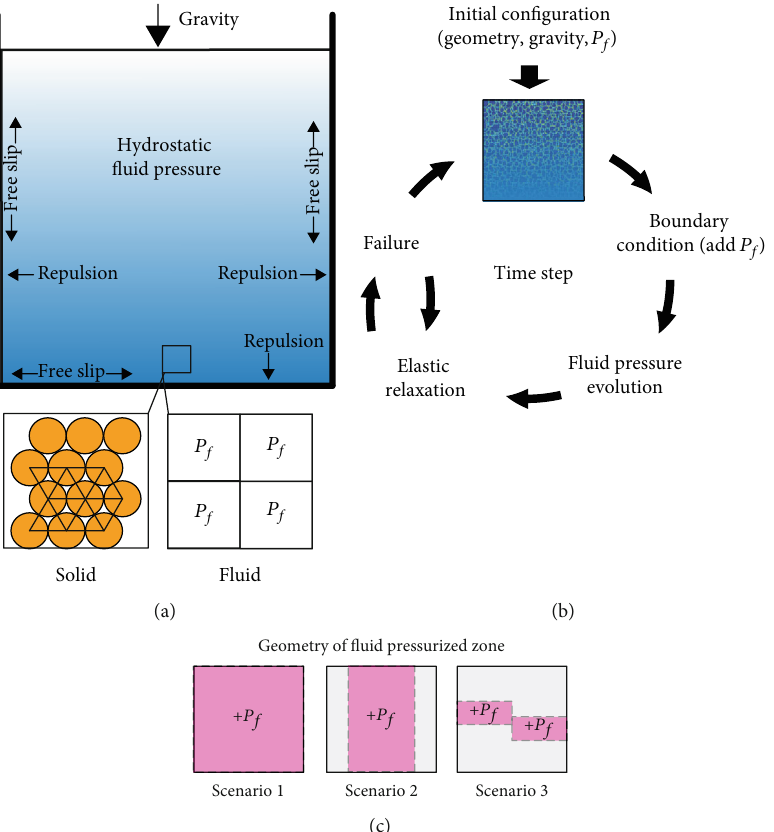
Figure 2: Setup of the numerical model. (a) Model box with free-slip elastic walls at the bottom and the right- and left-hand side and a stress boundary at the top. The inset shows the lattice for the elastic solid and the fl uid, respectively. (b) Simulation setup with the initial con fi guration followed by an input of fl uid pressure, the fl uid pressure evolution, the elastic relaxation, the internal failure until the model is relaxed, and the repetition of the time step. (c) Geometry of the source zones where fl uid is introduced successively during model runs for the 3 di ff erent scenarios modelled. Source zones are shown in